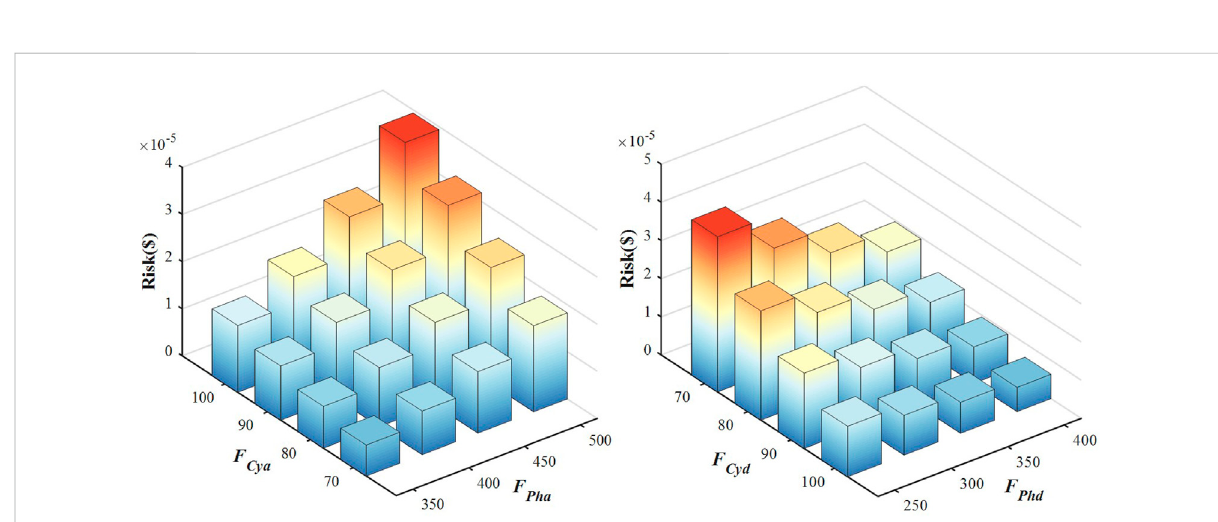
FIGURE 9 The impact of changes in attack and defense funds on the risk expectations of the test